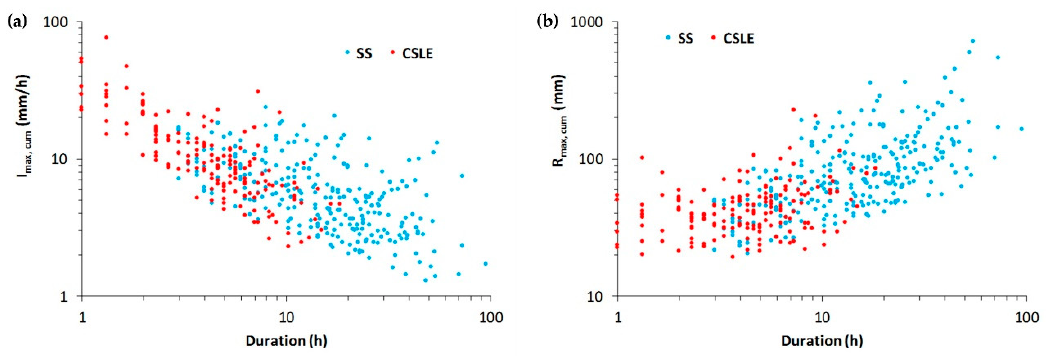
Figure 4. Plots for I max, cum ( a ) and R max, cum ( b ) with respect to event duration. Consequently, a second level of event classification was carried out, inside the SS group.